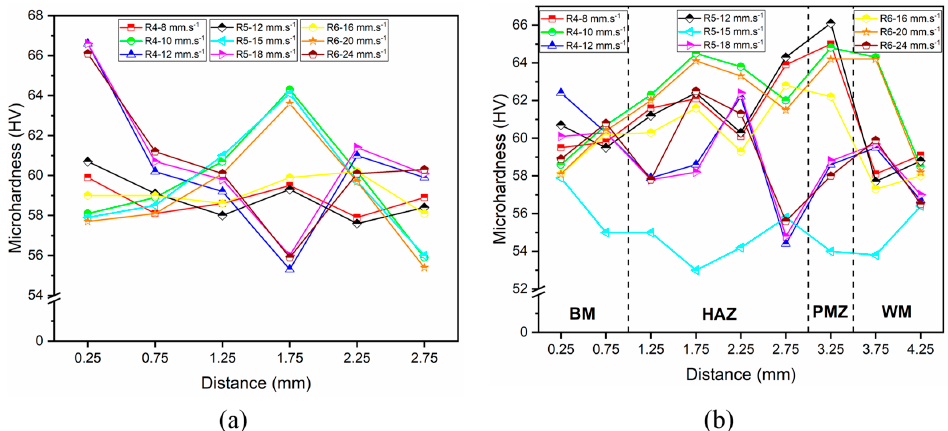
Figure 9. ( a ) Microhardness value of weld metal (WM) in vertical distribution across the center of WM from top bead to back bead and ( b ) microhardness value of horizontal distribution across the area of base metal (BM), HAZ, Partially Melted Zone (PMZ) and WM